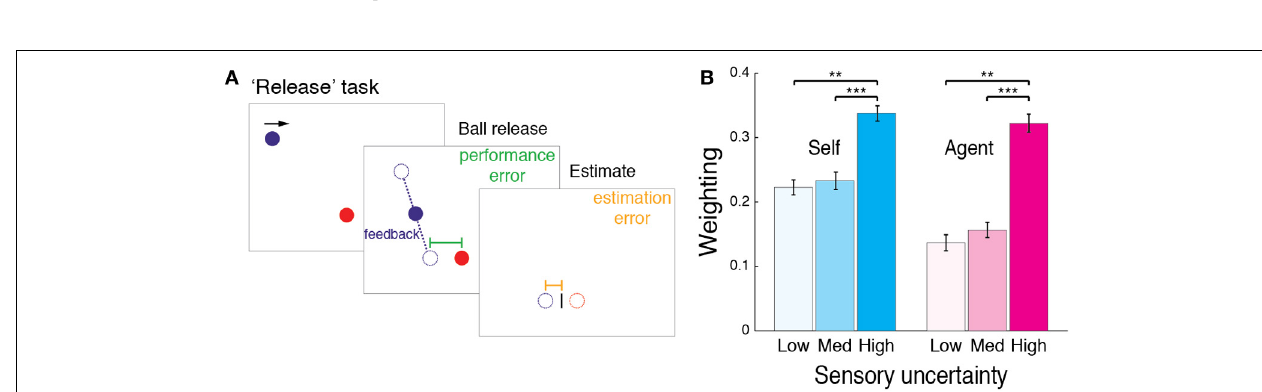
FIGURE 4 | “Release” task in Experiment 2. (A) In the Release task, participants released the ball (Self) or observed it being released (Agent), so as to drop it onto a target. We varied the visual feedback in one of three ways: by only displaying the ball as it reached the target plane; displaying it briefly at the halfway point; or not displaying the ball after release. This